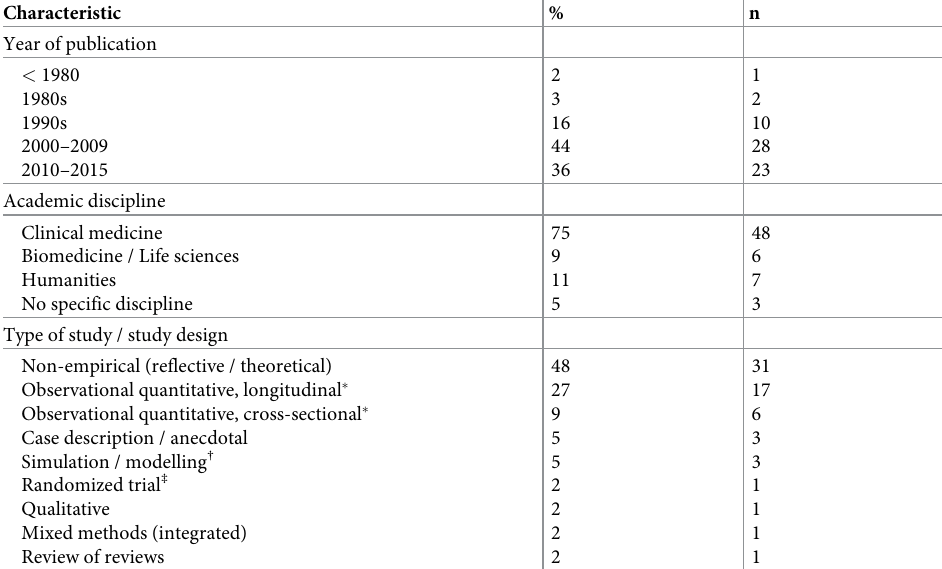
Table 1. Characteristics of the 64 analyzed